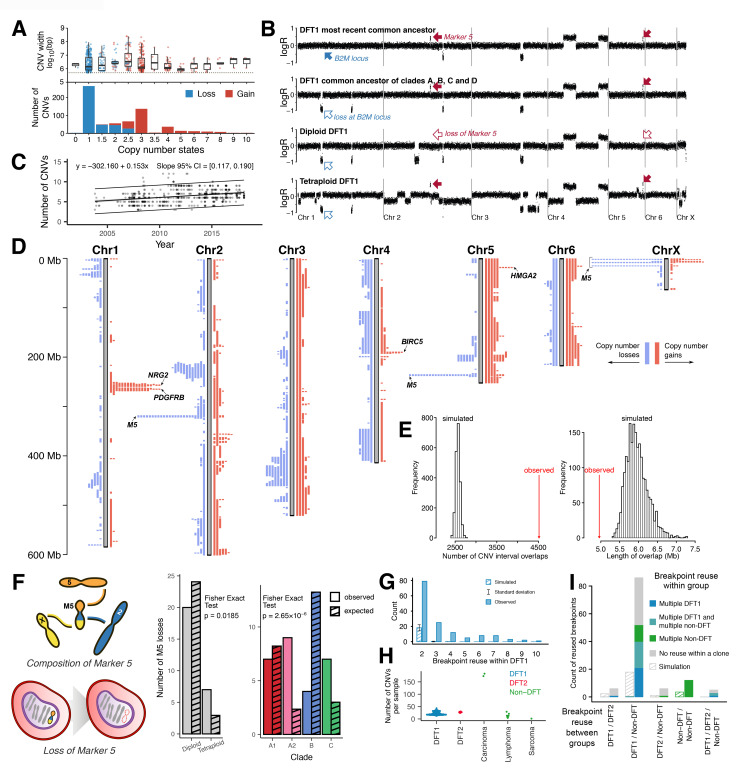
Copy number variation in DFT1.(A) Distribution of diploid DFT1 CNV states and widths, measured in bp. Subclonal copy number states are labelled 1.5, 2.5, and 3.5, and represent subclonal states between the two closest integer states. CNVs occurring after a whole genome duplication event are excluded. Gain and loss CNVs with CN2, loss CNVs with CN >2, and gain CNVs with CN <2 represent back mutations. The CNV detection limit was 500 kb (dotted line). Data are available in S3 Table. (B) Representative DFT1 copy number plots. Each dot represents normalised read coverage within a 100-kb genomic window. Tumour identities are, top to bottom, 377T1 (clade E), 56T2 (clade C), 228T1 (clade A2), and 209T3 (clade A1). The diploid tumour, 228T1, has lost M5, whose CNVs are visible on chromosomes 2 and 5 (red arrows). A CNV encompassing major histocompatibility complex class I component B2M was acquired in the common ancestor of clades A, B, C, and D (blue arrows). Copy number plots for all tumours are available in S2 Data in https://doi.org/10.5281/zenodo.4046235. (C) Rate of DFT1 CNV acquisition. Each tumour is represented by a grey dot, and labels mark 1 January of the labelled year. Sets of CNVs cooccuring with the same copy number in the same samples are counted once. CNVs are called relative to the reference genome. Grey shading represents regression standard error, and upper and lower lines represent prediction intervals. We corrected for ploidy in tetraploid tumours, and cell lines are excluded. Data are available in S1 Table. (D) DFT1 CNV chromosome map. Grey bars represent chromosomes with scale on left in Mb. Blue and red bars represent copy number losses and gains, respectively. Each bar is an independent CNV occurrence, and CNVs shared between tumours via a common ancestor are illustrated once. Each CNV step away from CN2 is illustrated separately. Candidate driver genes within frequently amplified regions are annotated, and complete lists of genes within CNV intervals are found in S6 Table. CNVs associated with M5 are indicated. HMGA2 is not annotated in the reference genome, Devil7.1, but is inferred to be present in the labelled interval based on cross-species genome alignment. CNVs occurring exclusively in DFT1 cell lines are excluded. CNV data are available in S3 Table. (E) DFT1 CNVs are more clustered than expected by chance. Number and length of overlapping CNVs in observed data and in data derived from 2,000 simulations. CNV data are available in S3 Table. (F) Loss of small derived chromosome M5 in diploid and tetraploid DFT1s and across DFT1 clades. M5 was acquired in a DFT1 common ancestor and is composed of fragments of chromosomes 2, 5, and X; this chromosome has been repeatedly lost in the DFT1 lineage (cartoon). The Fisher exact tests compare the observed distribution of M5 losses to those expected by chance, with the latter calculated assuming equal opportunity for M5 loss across all M5–positive tumours, correcting for change in opportunity caused by tetraploidy. Data are available in S8 Table. (G) Frequency of CNV breakpoint reuse within 567 DFT1 biopsies (cell line breakpoints excluded). Ends of chromosomes, M5 CNVs, and instances of reuse within individual samples are excluded from count. Simulated data are derived from 2,000 neutral simulations. Data are available in S9 Table. (H) Number of CNVs in Tasmanian devil cancers of different histotypes. “Lymphoma” includes two unspecified cutaneous round cell tumours (S1 Table). CNVs exclusive to DFT1 cell lines are excluded. Number of CNVs is relative to the reference genome. Each tumour is plotted as a dot, and each non-DFT data point represents an independent clone except for the three dots representing tumours 106T1, 106T2, and 106T3, which are separate tumours belonging to a single non-DFT cancer. Data are available in S1 and S3 Tables. (I) Frequency of CNV breakpoint reuse across Tasmanian devil cancers. Number of reused breakpoints between pairs or trios of devil cancer groups are shown, with colours indicating the number of breakpoints within each category which are also reused within individual devil cancer cohorts. DFT1 cell line CNVs, ends of chromosomes, M5 CNVs, and reuse within individual samples are excluded from count. Simulated data are derived from 2,000 neutral simulations of datasets of the same size. Simulated data are coloured for breakpoint reuse within group using the same colour key as used for real data, as shown on the plot. None of the reused breakpoints were found in the genomes of normal devil tissues, including those of matched hosts (S1 Table). Non-DFT, spontaneously arising non-transmissible devil cancers that are neither DFT1 nor DFT2. Data are available in S9 Table. bp, base pair; CI, confidence interval; CN, copy number; CNV, copy number variant; CN2, copy number 2; DFT1, devil facial tumour 1; LogR, ratio of tumour to normal reads, log base 2; Mb, megabase; M5, marker 5.